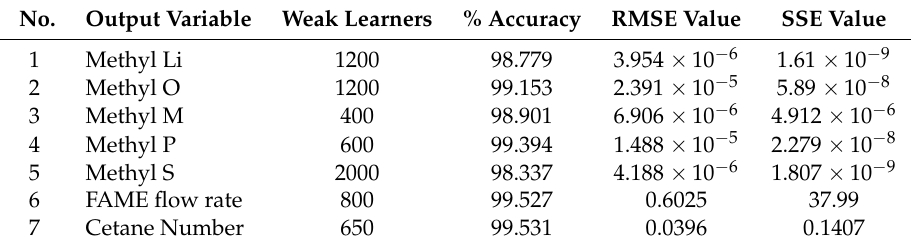
Table 3. In the PCE based method, Hermite function was used for a level of 6 and initial 20 terms. Table 3. Summary of soft sensors